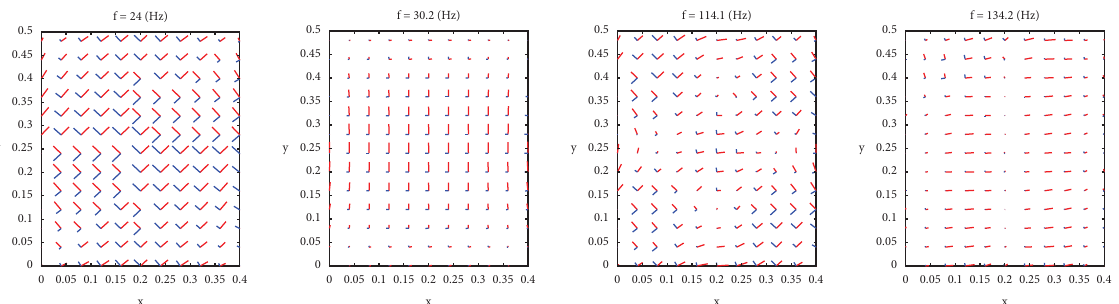
Figure 7: Principal strain arrangements of four natural modes.